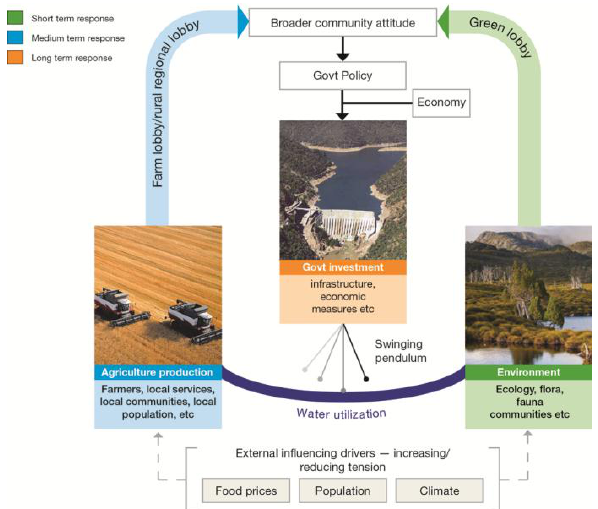
Fig. 6. Framework for socio-hydrologic modelling: interactions and Fig 6 feedbacks between human and environmental systems leading to new (whole system)